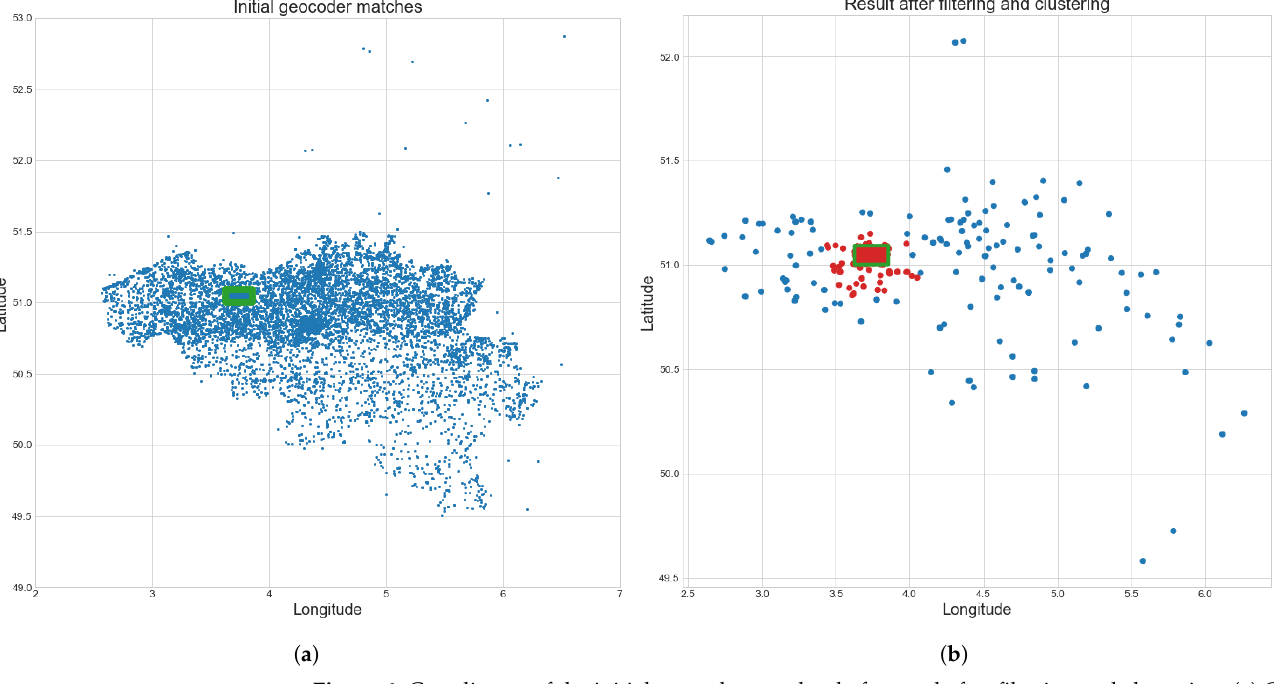
Figure 6. Coordinates of the initial geocoder matches before and after filtering and clustering. ( a ) Co- ordinates of the initial geocoder matches. The green rectangle denotes the ground truth geolocation of the map. The shape of Belgium is visible in the distribution of points (extreme outliers are not shown to improve the visibility of the figure). ( b ) The result after filtering and clustering of the initial coordinates. The largest cluster found is shown in red. The green rectangle denotes the ground truth geolocation of the